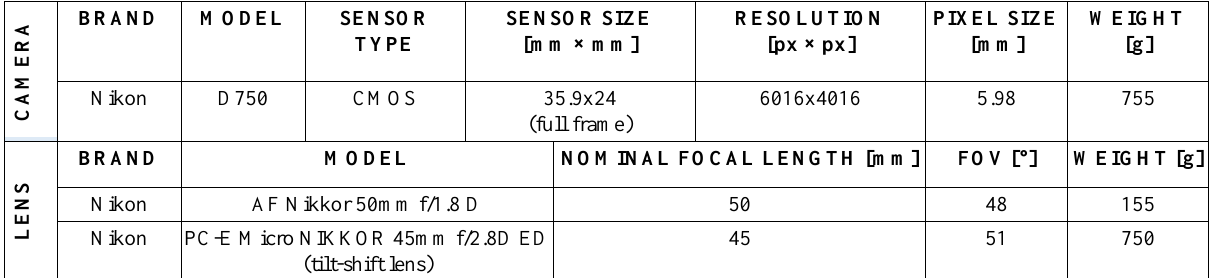
Table 1. Photogrammetric